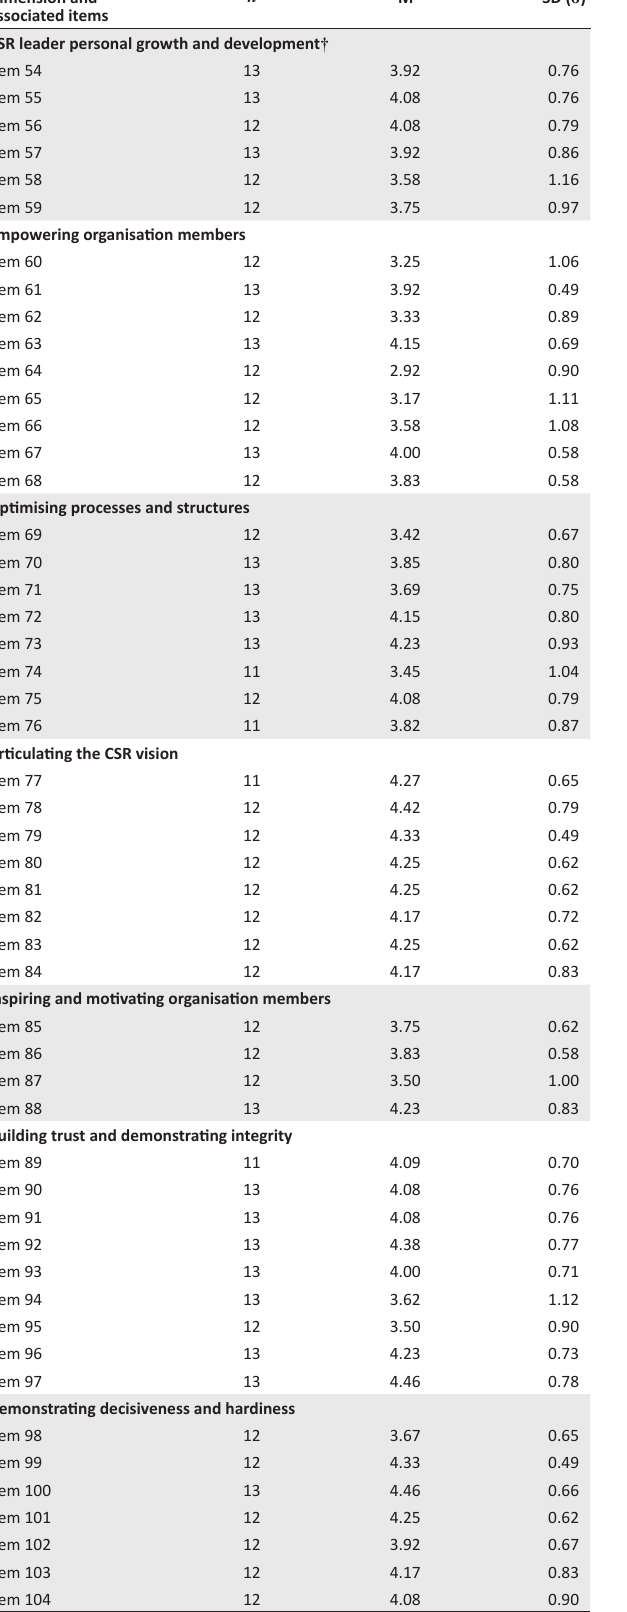
TABLE 3 (Continues...): Descriptive statistics results for item ratings by expert judges. Dimension and associated